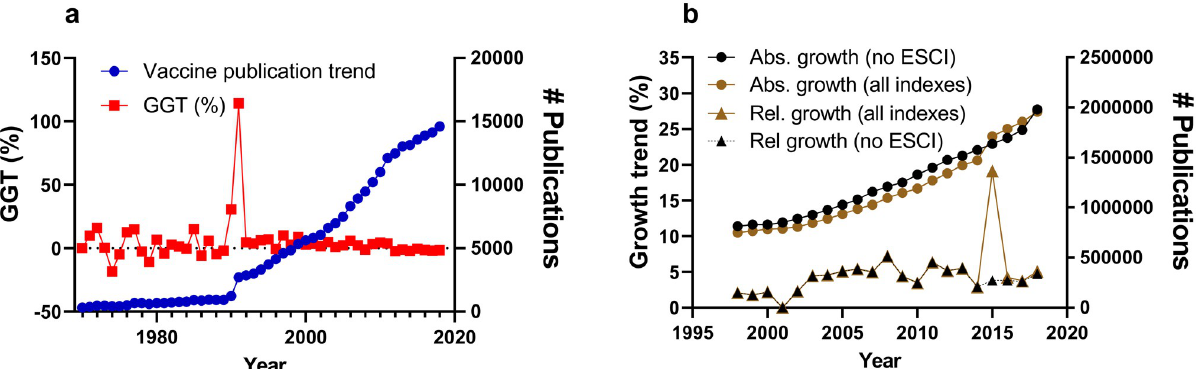
Fig 2. The effects of index changes. a) The publication trend (blue circles) for articles and reviews (right-axes) and GGT (red squares; left-axes) for the search string: TS = (vaccin � ) AND PY = (1970–2020) on WoS excluding the ESCI index. b) The absolute number of publications (right y-axes; circles) and relative yearly percentage increase (left y-axes; triangles) in total publications reported on WoS using all indexes (brown) of WoS or all but the ESCI index (black). Spikes in the GGTs and growth trends indicate the inclusion of keyword searches in abstracts in 1991 (a) and the inclusion of the ESCI index in 2015 (b)